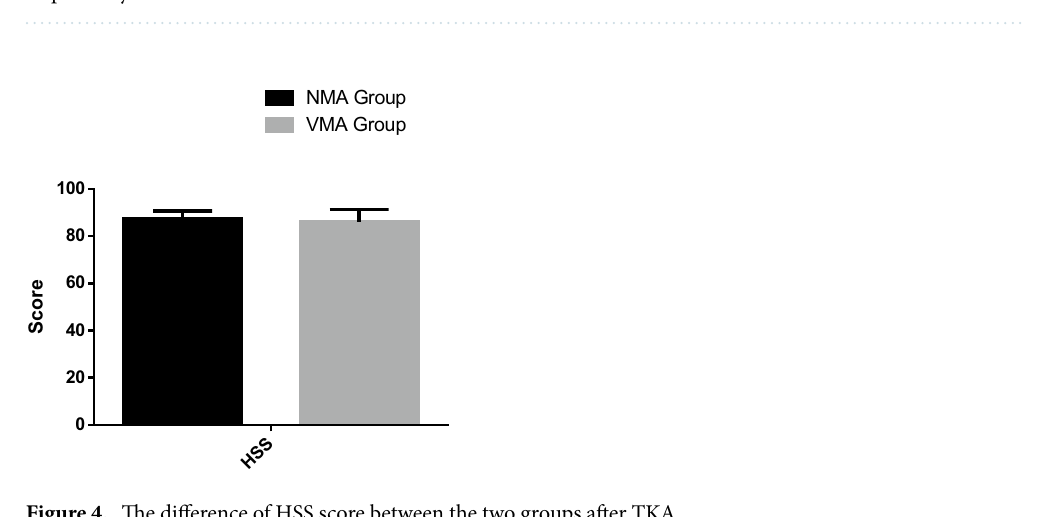
Figure 3. Statistic differences between preoperative and post-operative HSS score, MPTA, LDFA, HKA angles, respectively.